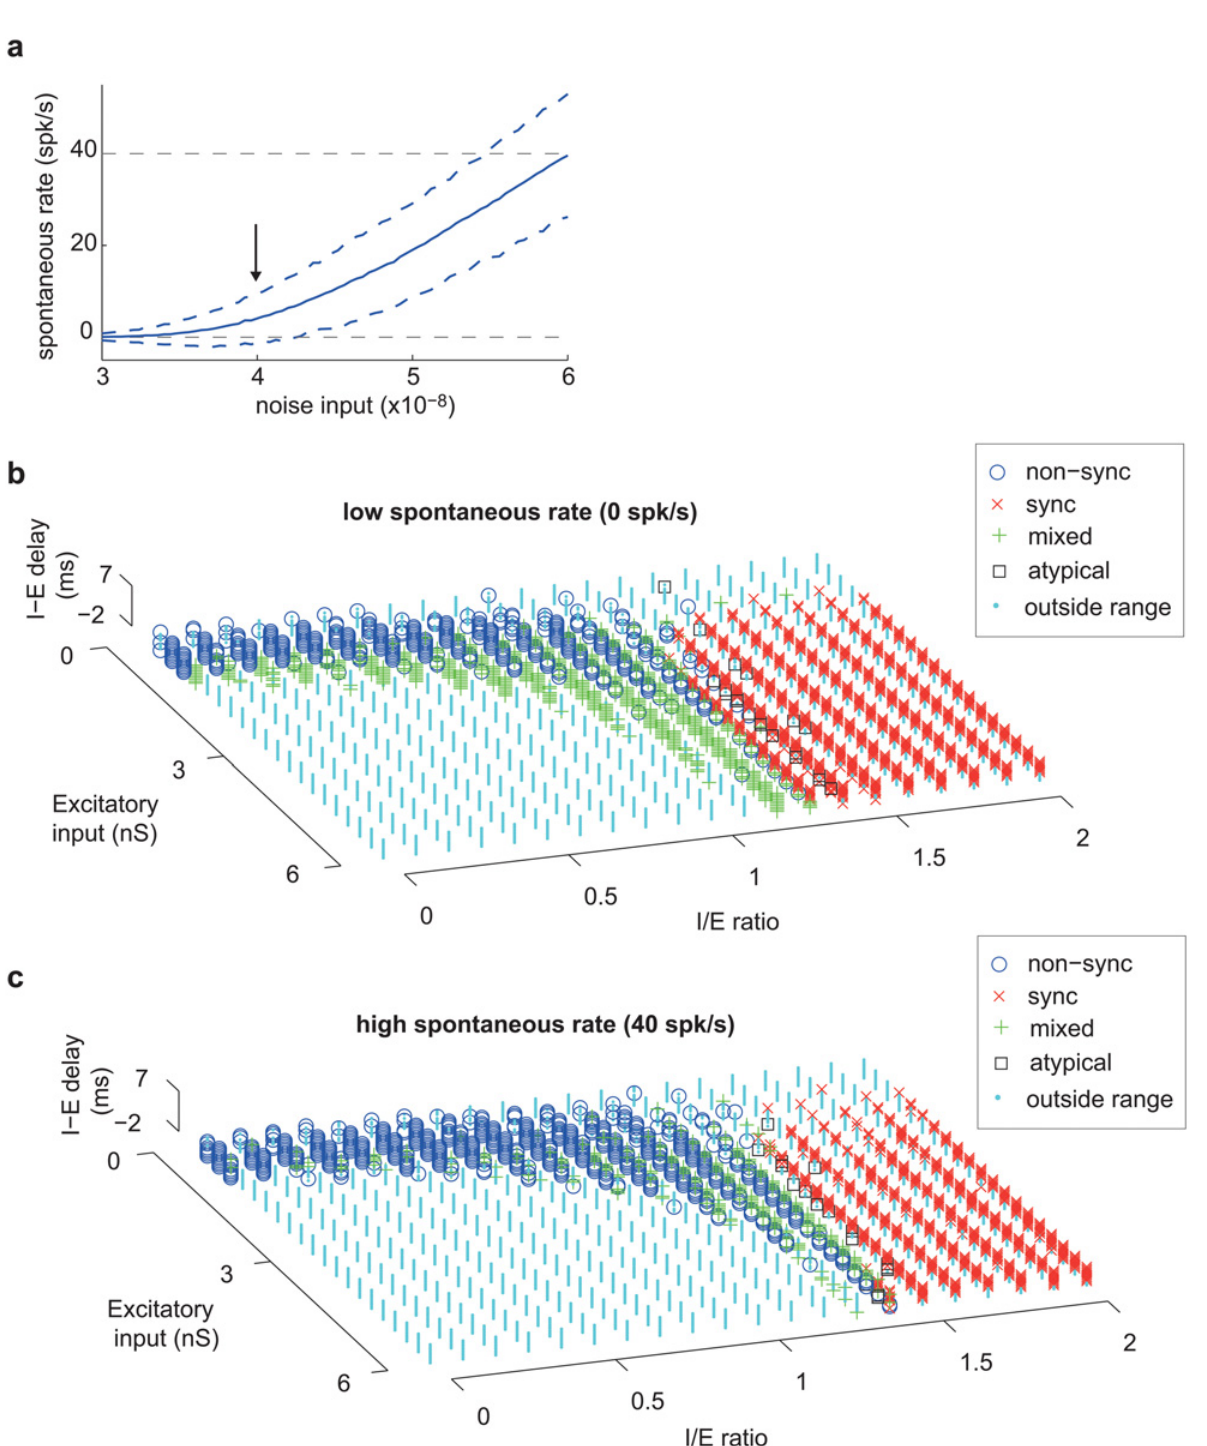
Fig 9. Impact of spontaneous rate on computational model. a. Relationship between spontaneous rate of simulated neuron and the amplitude of the Gaussian noise added to the excitatory and inhibitory conductances. The arrow indicates the amplitude of noise used for the simulated neurons in analyses conducted in Figs. 2 – 8. The gray dashed lines indicate spontaneous rates of 0 spk/s (bottom) and 40 spk/s (top). b-c. Classification of neuron-type [non-sync (o), sync (x), mixed (+), atypical (square)] for two different spontaneous rates: a low spontaneous rate (b) of 0 spk/s (noise input of 3x10 -8 ) and a high spontaneous rate (c) of ~40 spk/s (noise input of 6x10 -8 ). Responses outside the allowable range (pure tone response between 1 – 50 spk/s) are indicated in